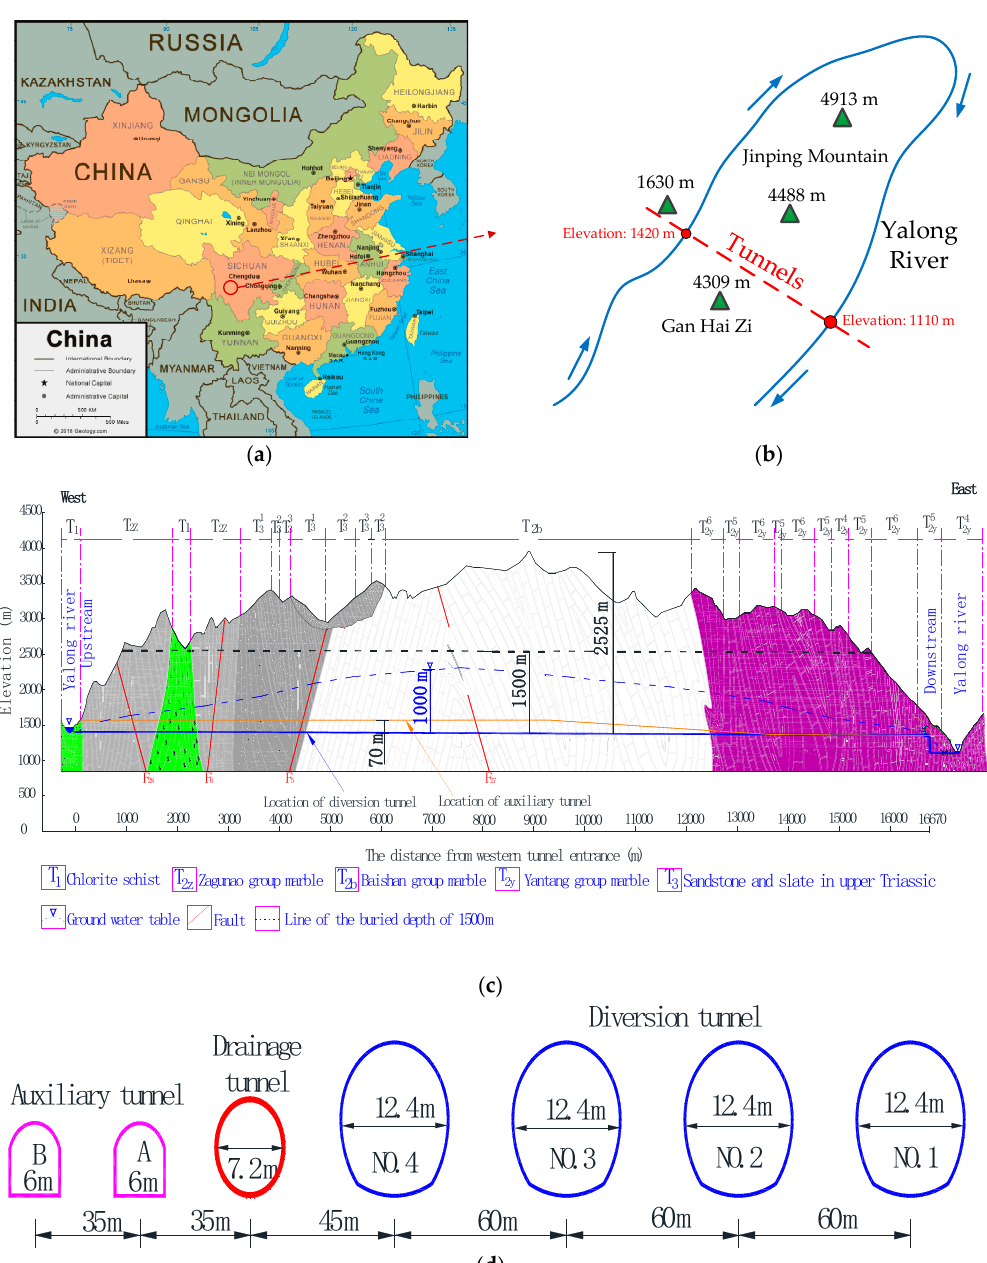
Figure 1. Deep tunnels of Jinping II hydropower station: ( a ) Map of China and location of the station; ( b ) plan of the station; ( c ) engineering geologic profile; and ( d ) layout and cross section of the tunnels.